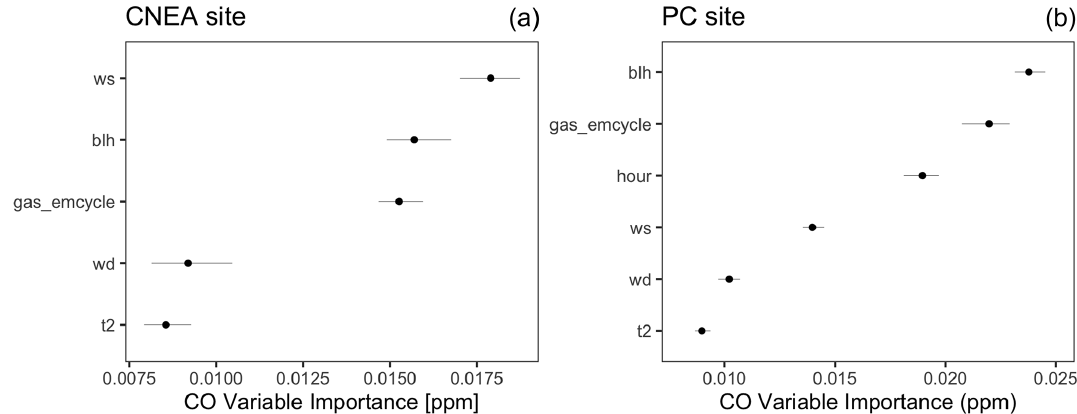
Figure 5. Variable importance plot (permutation difference) for CO variables (ppm) in CNEA (a) and PC (b) for the RF model.